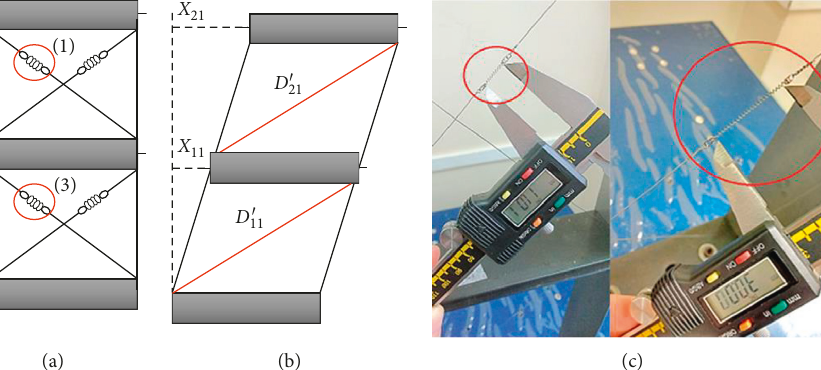
Figure 6: Coupling of the springs in the structure. (a) Illustrative representation of the arrangement of the elements, (b) procedure for measuring the deformation of the SMA-SE coil springs, and (c) calibration procedure for the springs.